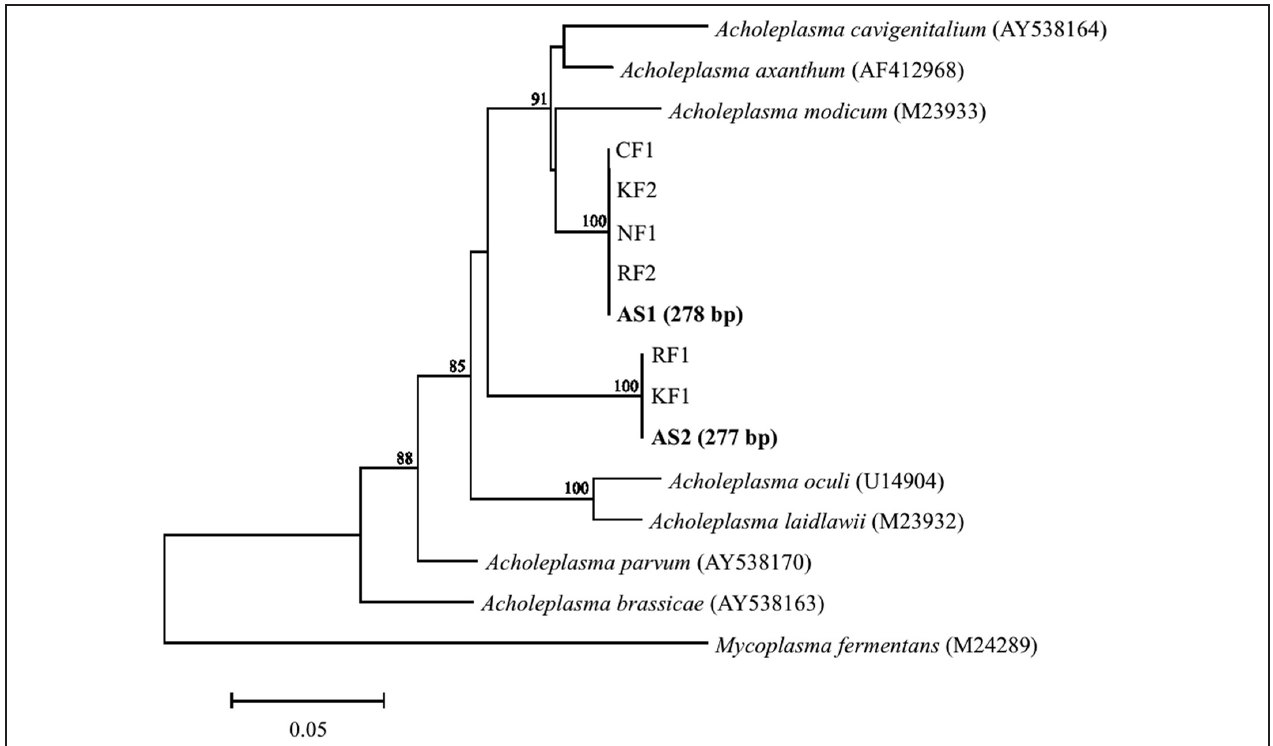
FIGURE 3 | Phylogenetic tree generated with the neighbor-joining method showing relationships among clones obtained from aerated pig manure slurry samples. Clones were designated AS (heavy fraction of 13 C-labeled sample, in boldface) and RF, NF, CF, or KF (sequences obtained from slurry from four different pig farms). Numbers in parentheses for AS1 and AS2 represent expected T-RF lengths of clones. Bootstrap values are shown at each node that had > 70% support in a bootstrap analysis of 1,000 replicates. Scale bar represents 5% sequence divergence. DNA Data Bank of Japan/European Molecular Biology Laboratory/GenBank accession numbers of reference sequences are